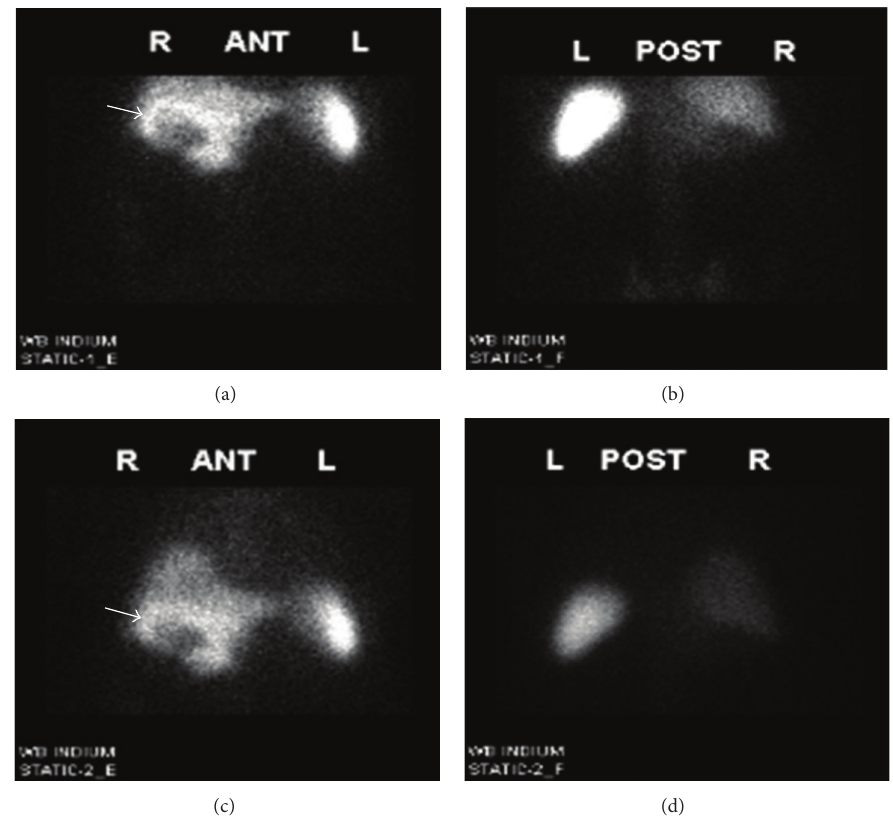
Figure 1: Twenty-four hours Indium-111 WBC gallbladder scan reveals increased accumulation of 111 in-leukocytes within the gallbladder wall suggestive of hyperemia/inflammatory changes in the pericholecystic region (arrow) (donut sign).